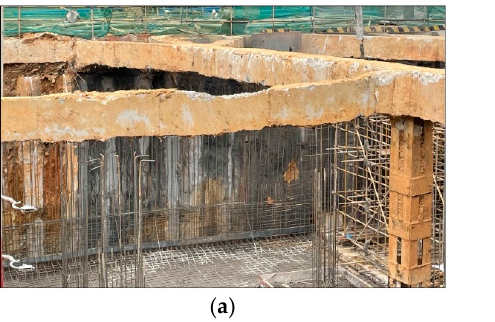
site. Set evidence P (F = Low, B9 = No, B10 = No, B11 = No, B4 = No, B5 = No, B7 = Yes) = 1, as shown in Figure 17b. There were no large weak interlayers in the accident site (P (C17 = Low) = 35.1%) and no irregularity in the operation of machinery (P (C19 = Low) = 26.4%). However, the excavation speed of the pit was too fast (P (C18 =Yes) = 4.69%). At this point, the construction team immediately stopped construction and adjusted the excavation plan. It is worth mentioning that at this point, the tunnel lateral was located within a rea- sonable range. Setting evidence P (C18 = Low, C19 = High) = 1, no DSTS (B6) was noticed to occur during the subsequent inspections. On 14 March 2022 (T14), the uplift of the center column at the bottom of the 94 th axis of the foundation pit reached 2.14 mm. Based on the previous evaluation logic, the de- watering well between the 92nd and 94th axis had a sudden surge (P (B5 = YES) = 6.98%). As shown in Figure 17c, during the inspection, two risk factors (SPF (C12) and HGL (C13)) occurred in the C-level under FPI (B5). The construction team filled in the small diameter stones at the time of the hazard and filled in the dry material concrete and micro expan- sion concrete. Figure 18b shows the scene at the time of the dangerous situation. It can be seen that there was a large amount of undrained sewage at the bottom of the pit. It is presumed that the accident occurred as a result of the increased rainfall at that time, cou- pled with the rupture of the sewage pipe near the pit, which led to the failure of the drain- age well and sewage pump due to overloading. In summary, this dynamic Bayesian net- work model for risk diagnosis can minimize the scope of finding risks and improve the efficiency of handling risky accidents. 6. Conclusions This study proposed a probabilistic prediction model for the construction risk of DFPs adjacent to existing underpass tunnels using the N–K model and dynamic Bayesian network. The Nanning underground comprehensive utilization project was taken as an example. The risk inference analysis of the DFP construction adjacent to the existing un- derpass tunnel was conducted from three aspects: probability prediction, sensitivity anal- ysis, and risk diagnosis, which verified the reasonableness and superiority of the model. The following conclusions were drawn: (1) Using the N–K model, this study quantified the coupling values of various risk factors in the construction accident of DFP of adjacent existing underpass tunnels in dif- ferent ways: T 4 > T 33 > T 32 > T 21 > T 23 > T 34 > T 31 > T 22 > T 26 > T 24 > T 25 . The results indicated that the more risk factors involved in the coupling, the greater the coupling value. How- ever, a phenomenon where the double factor coupling value is greater than the multi-